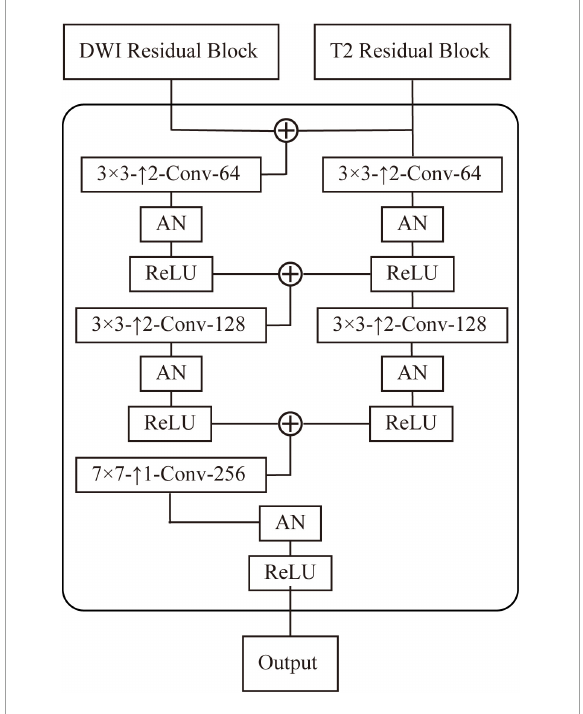
FIGURE5 Design of the decoder of generator, which contains three deconvolution layers, where 3 × 3 − Conv − 64 means a 3 × 3